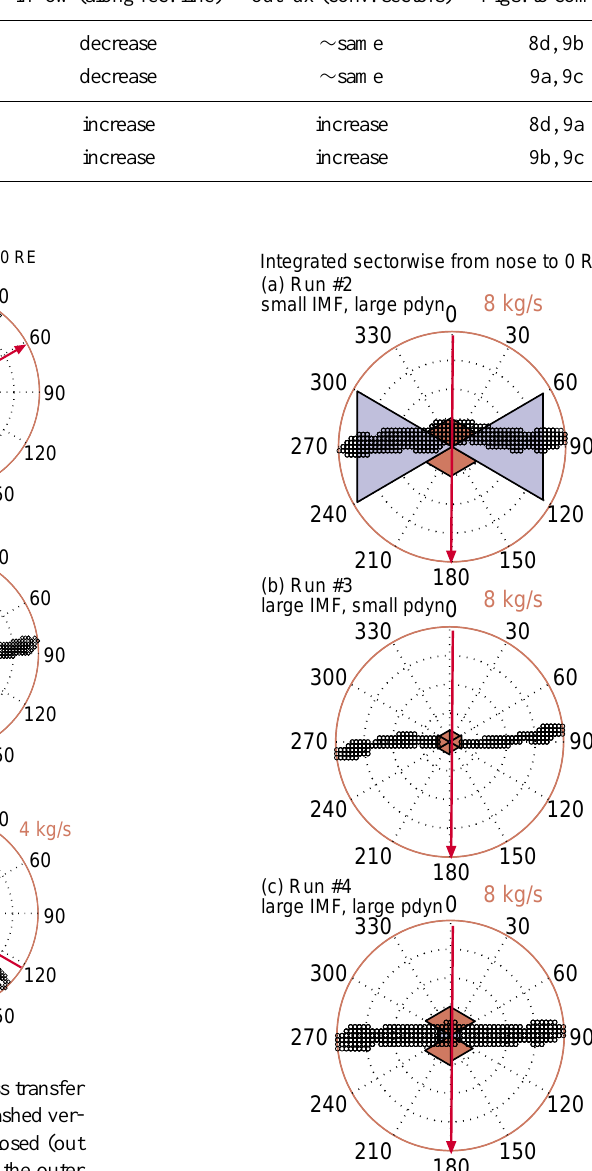
Table 2. Changes in mass transfer to closed field in different runs. inflow (along rec. line) outflux (conv. sectors) Figs. to compare